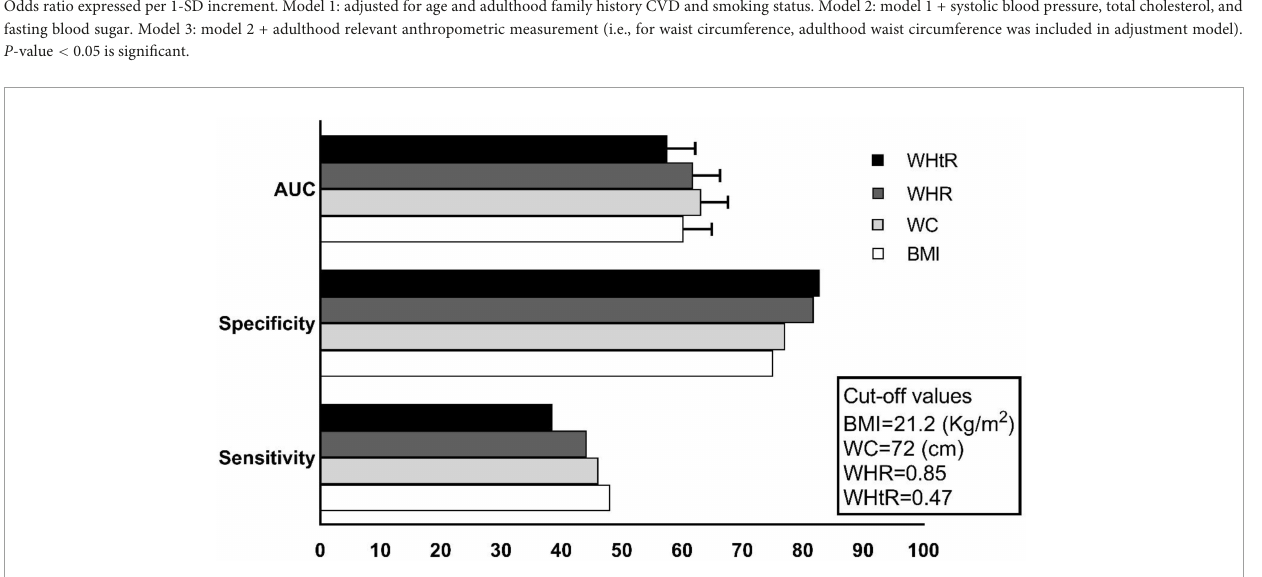
FIGURE1 The area under the curves (AUCs*100), sensitivity (%), specificity (%), and cut-off values of adolescent anthropometric indices for predicting high cIMT in